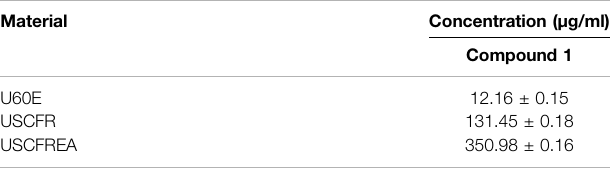
TABLE 2 | Concentration of compound 1 from Ulmus davidiana branch (with